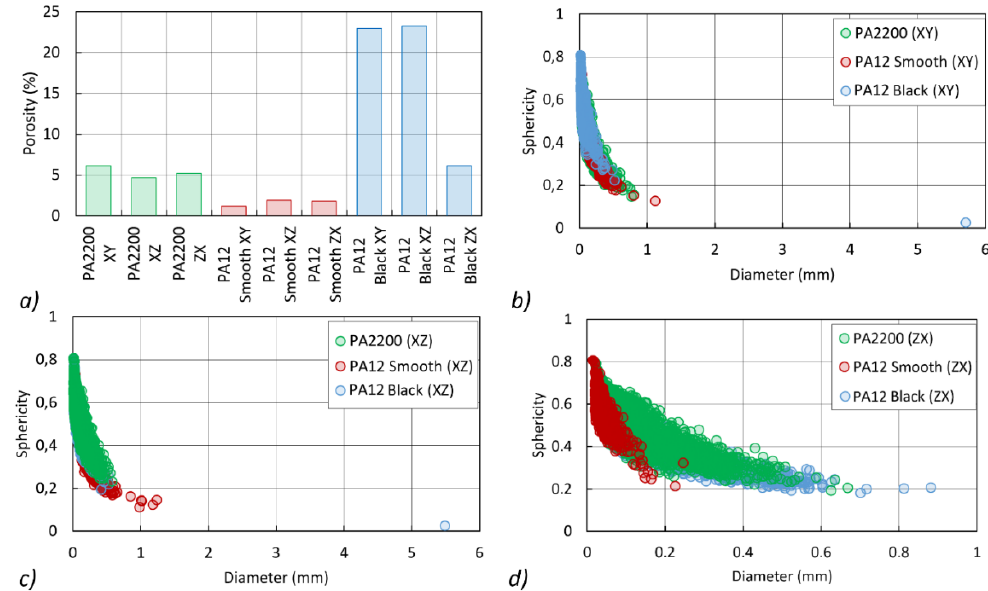
14 of 17 Figure 10. Porosity analysis: ( a ) sample PA12 Black XZ with analysed region of interest (ROI), ( b )